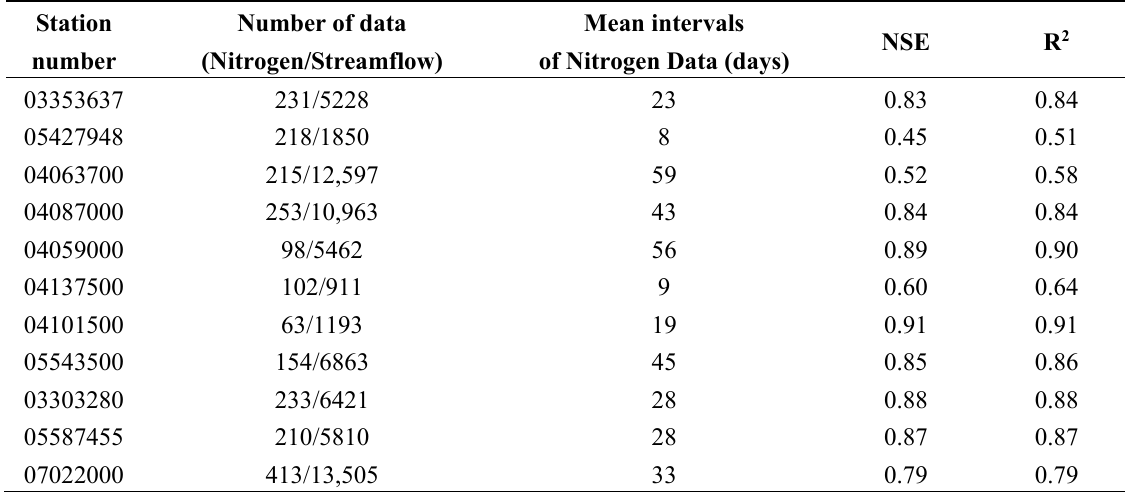
Table 2 . Nash-Sutcliffe Efficiency (NSE) and coefficient of determination (R 2 ) of estimated loads to measured load.